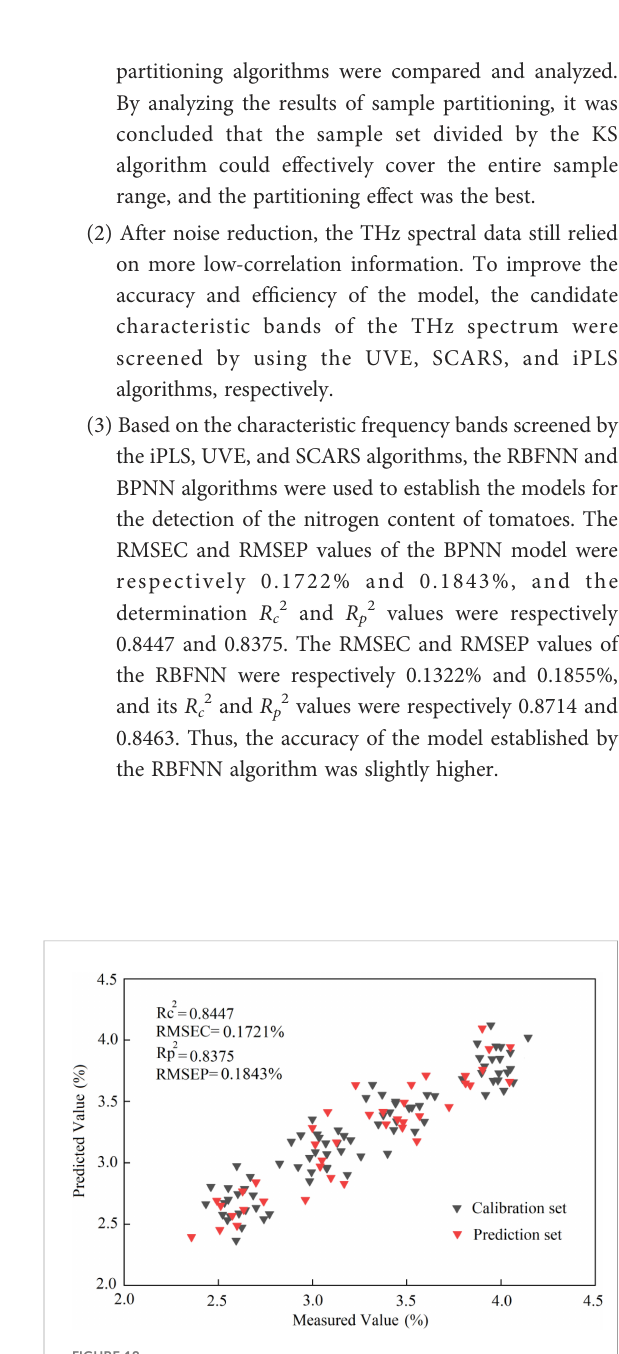
FIGURE 18 The scatter plot of the prediction results of the BPNN model based on THz spectroscopy.